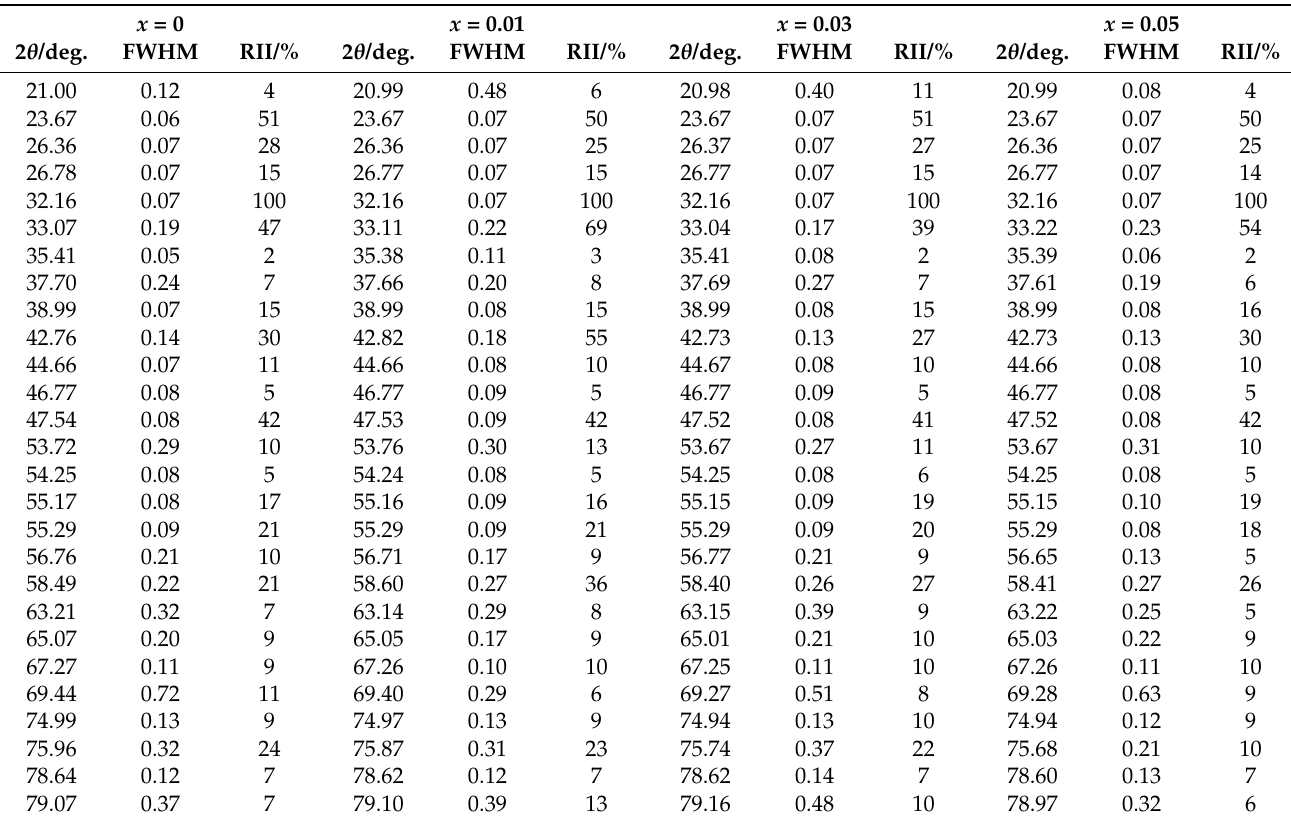
Table 1. Peak positions, full width at half maximum (FWHM), and relative integrated intensities (RII) of diffraction peaks for La 3 LiMnO 7